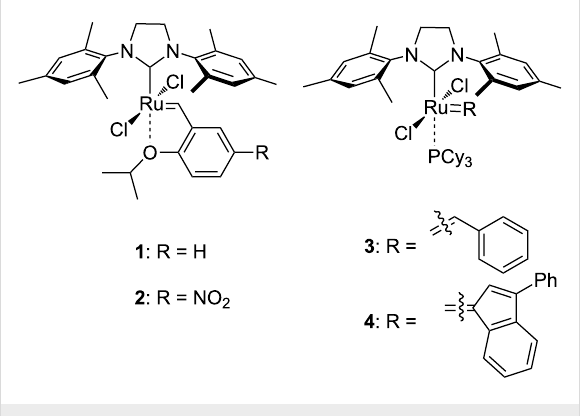
Figure 1: Catalysts 1–4 tested for the metathesis of profluorescent substrates.